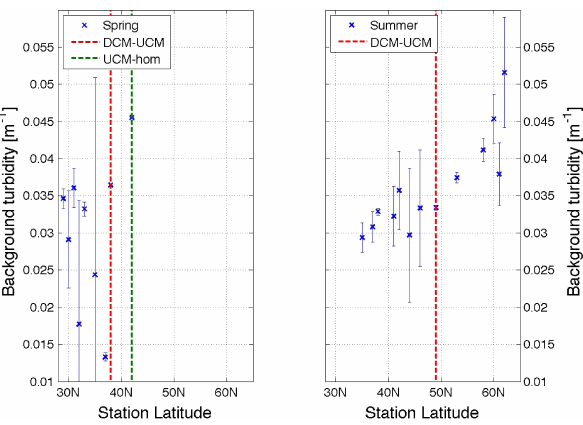
Figure A2. Mean K bg per station based on irradiance profiles measured in spring (left) and summer (right). Error bars give the standard deviation per station. The vertical dashed lines define the latitude at which the system changes its state: red is the transition from a DCM to a UCM state and green from a UCM to a homogeneously mixed state (from south to north).